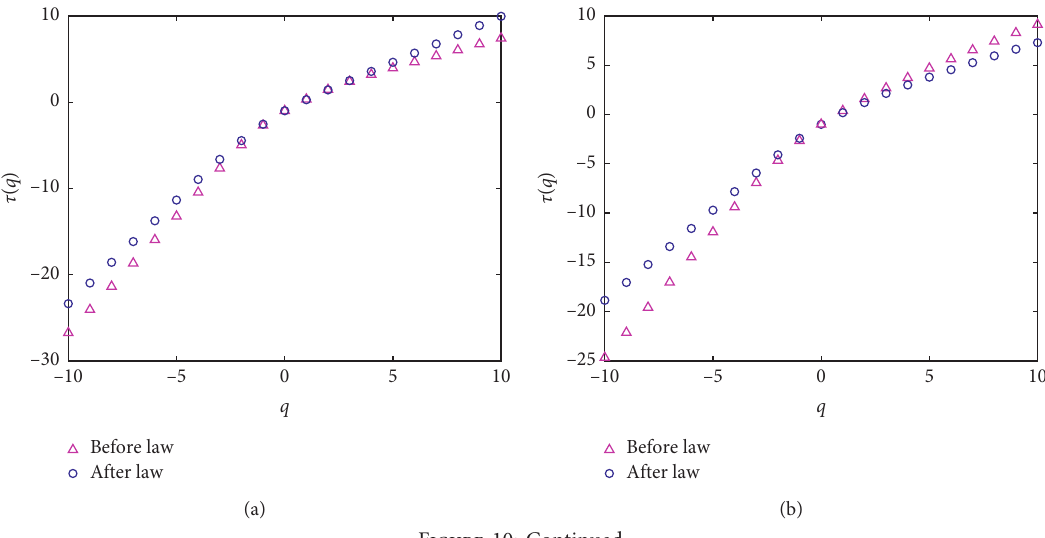
concentration of (a) Seoul, (b) Busan, and (c) Daegu. 2 . 5